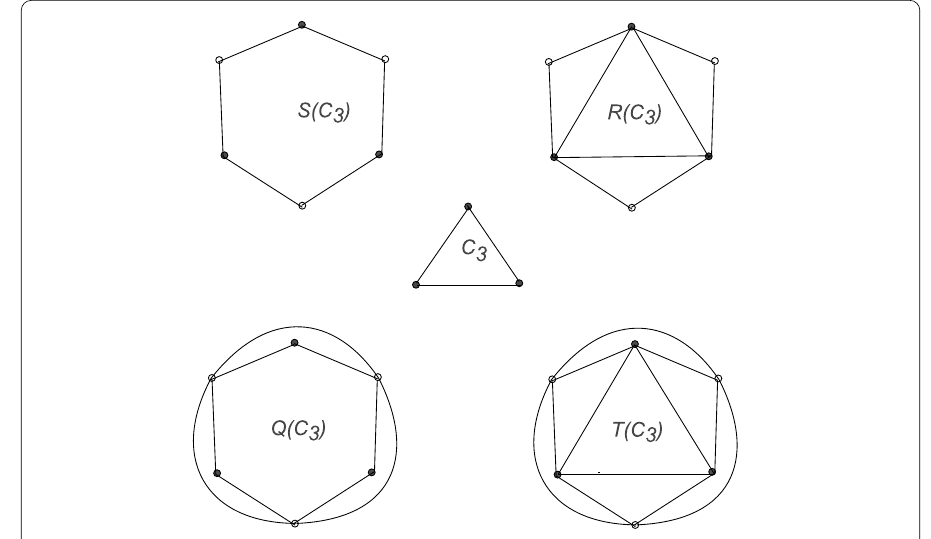
Figure 1 The graphs G , S ( G ), R ( G ), Q ( G ) and T ( G ).